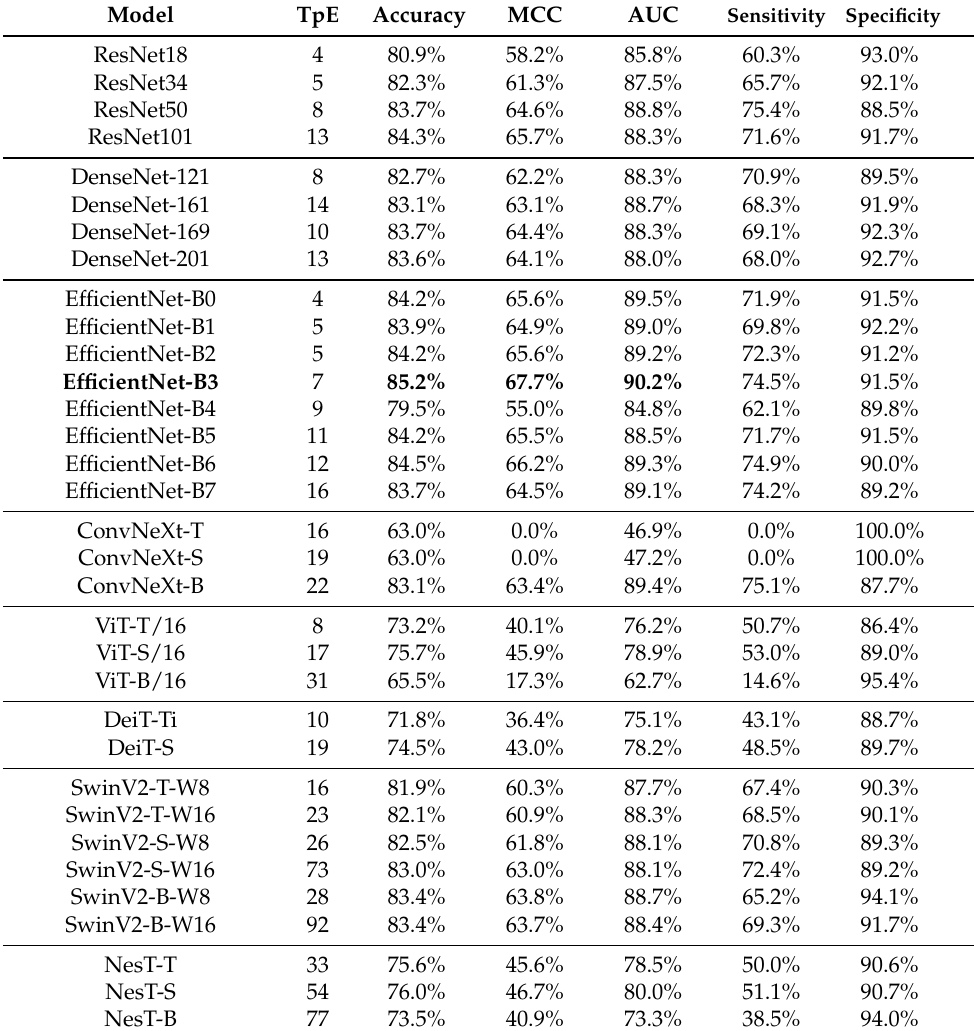
Table 3. Results of the experiments for each of the 33 architectures used. In bold the highest value of Accuracy, MCC and AUC. Column TpE indicates the training time per epoch in